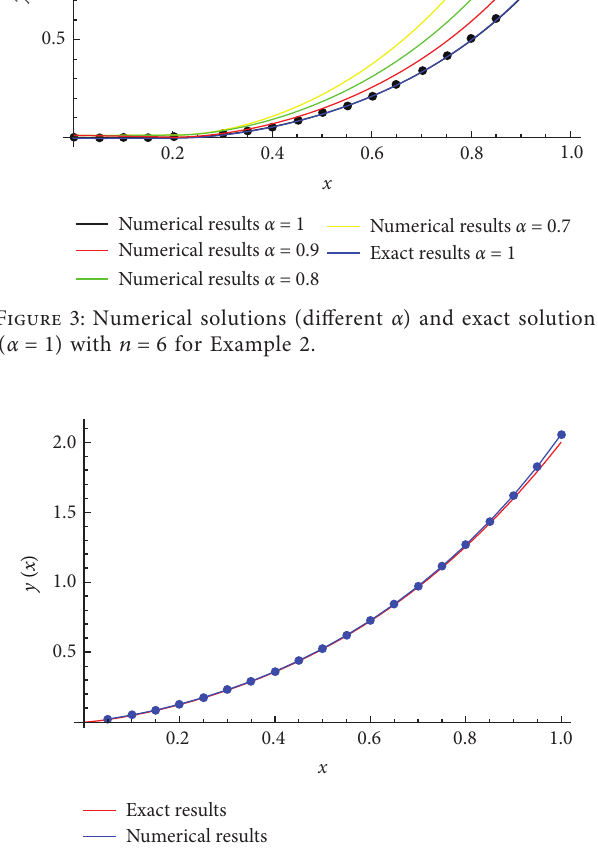
Figure 7: Comparison of the numerical solutions with exact so- lution for n � 12.